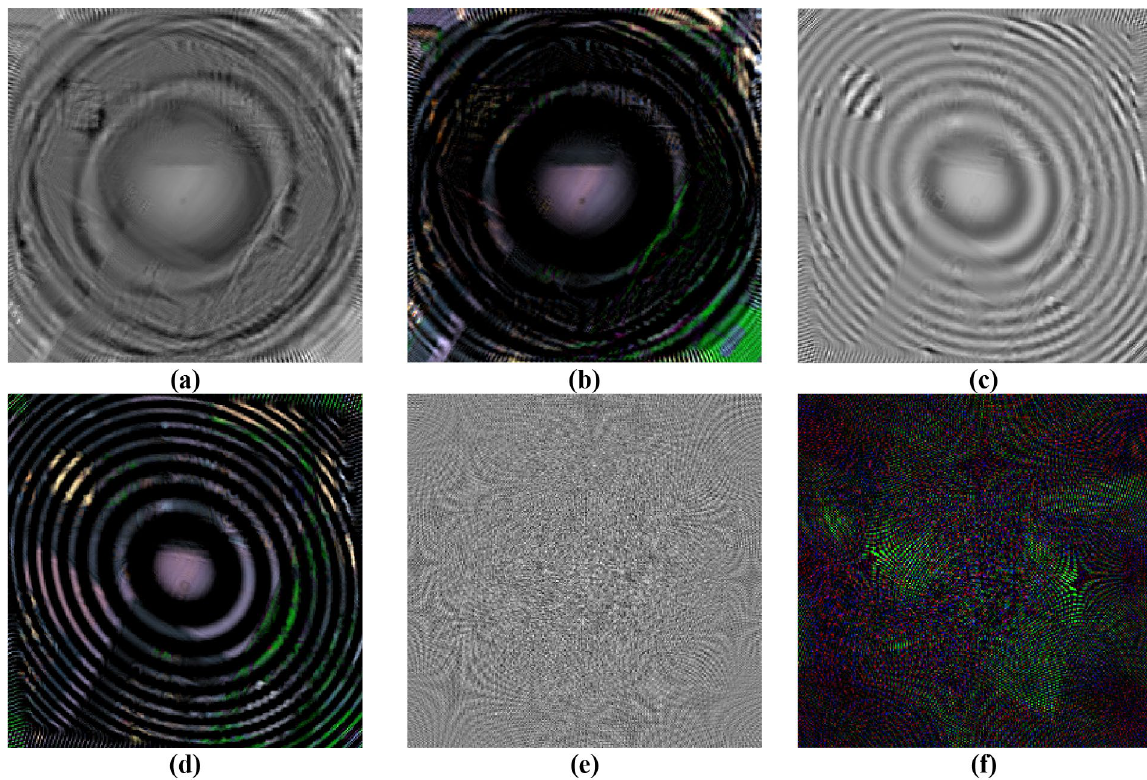
Figure 7. The decrypted results by using incorrect parameters in devil’s lens ( a ) single band format, ( b ) color format, incorrect focal length in Fresnel lens ( c ) single band format, ( d ) color format, incorrect p in RSPF ( e ) single band format and ( f ) color